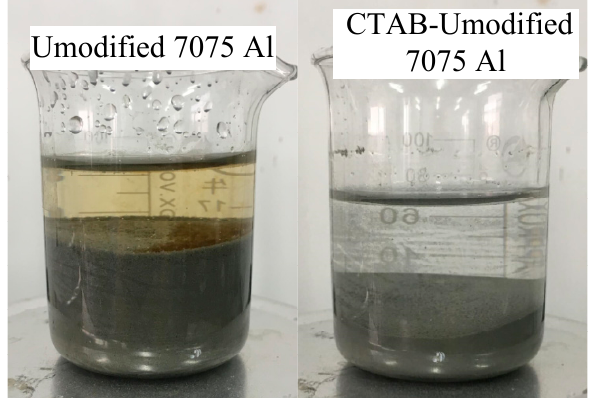
Figure 3. The image of mixture after 7075 Al powders absorbing GO.